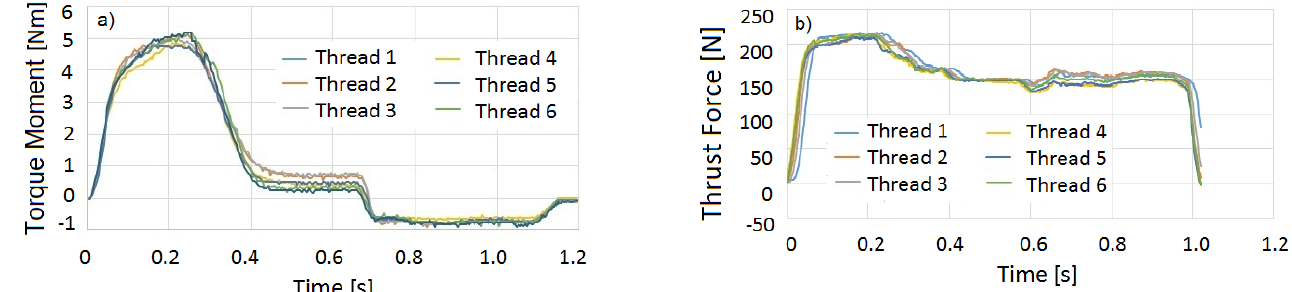
Figure 8. Typical time series measured when using the polymers. ( a ) Torque moment, ( b ) transla- tional force.